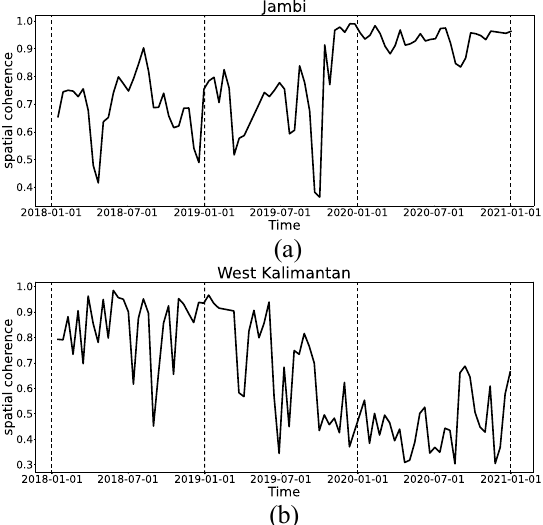
Figure 5. Time series of average spatial coherence. ( a ) Spatial coherence averaged over the red polygons in Figure 4a–c. ( b ) Spatial coherence averaged over the red polygons in Figure 4d–f. Oil palm plantation fields in West Kalimantan (latitude/longitude: −0.10/10.73) are